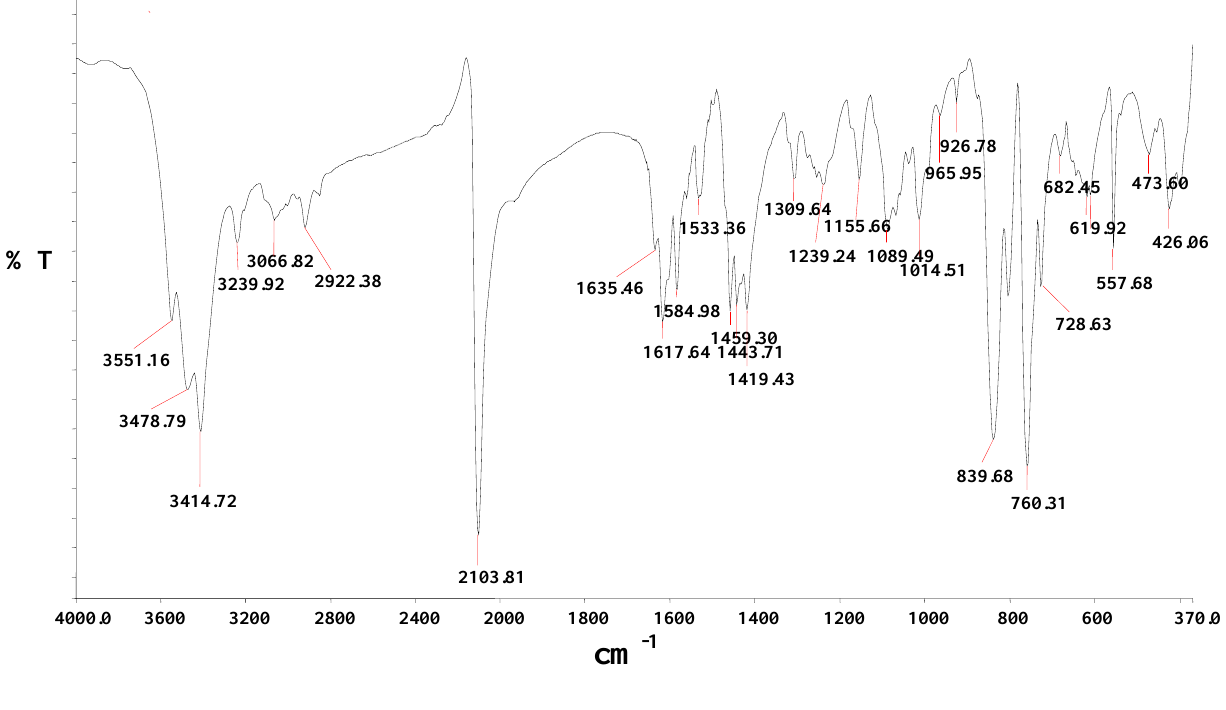
L (NCS) ] complex in 1 2 2